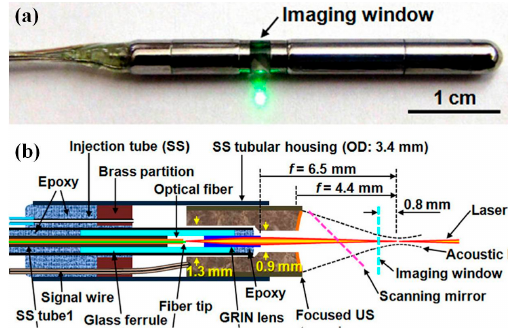
Figure 18. Photoacoustic endomicroscope (PAEM) for optical resolution in vivo imaging: ( a ) photograph of the PAEM probe showing the imaging window side; and ( b ) schematic drawing of the PAEM (Reproduced with permission from OSA [110]).